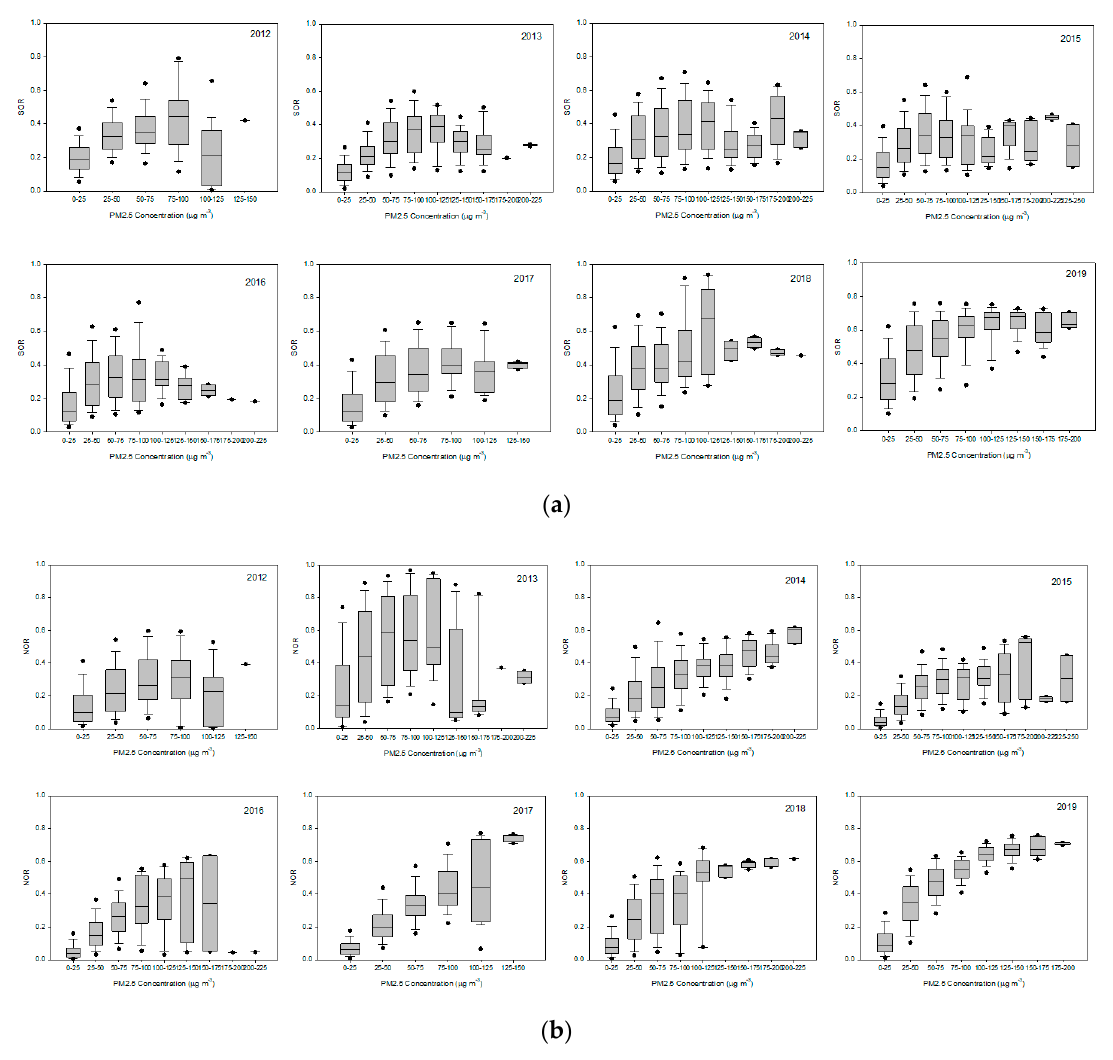
Figure 9. Changes in the SOR and NOR according to PM2.5 concentration in Seoul: ( a ) SOR; ( b ) NOR.